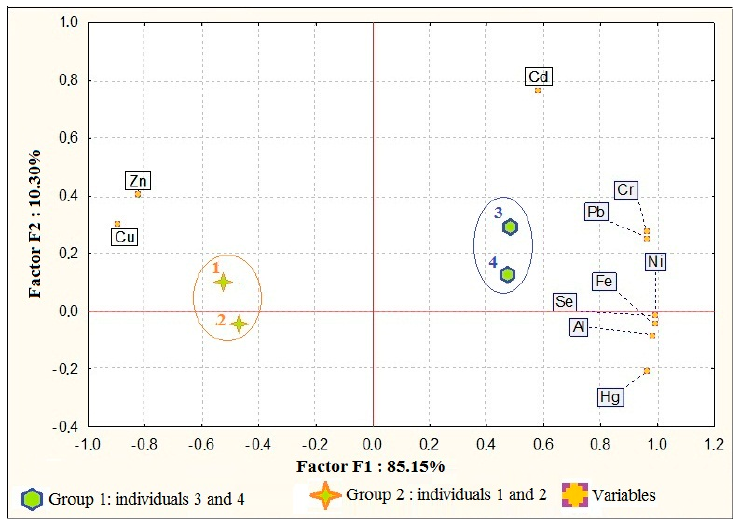
Figure 2. Projection and correlation circle of heavy metal data in Boukhalef River waters and sediments in the factorial plane F1 X